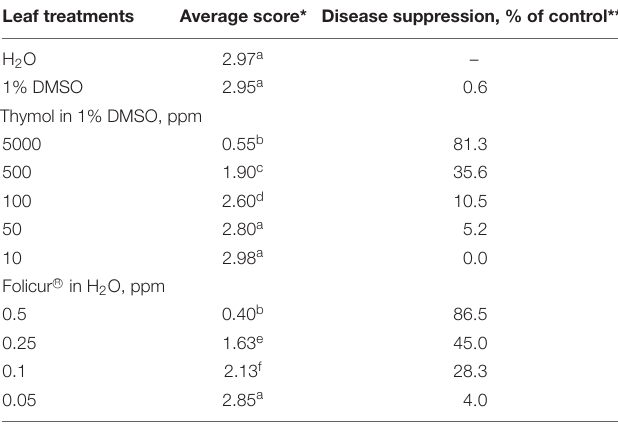
TABLE 1 | Effect of treatments of detached wheat leaves with Folicur R (cid:13) 250 EC or thymol solutions in DMSO on the severity of blotch symptoms caused by Parastagonospora nodorum